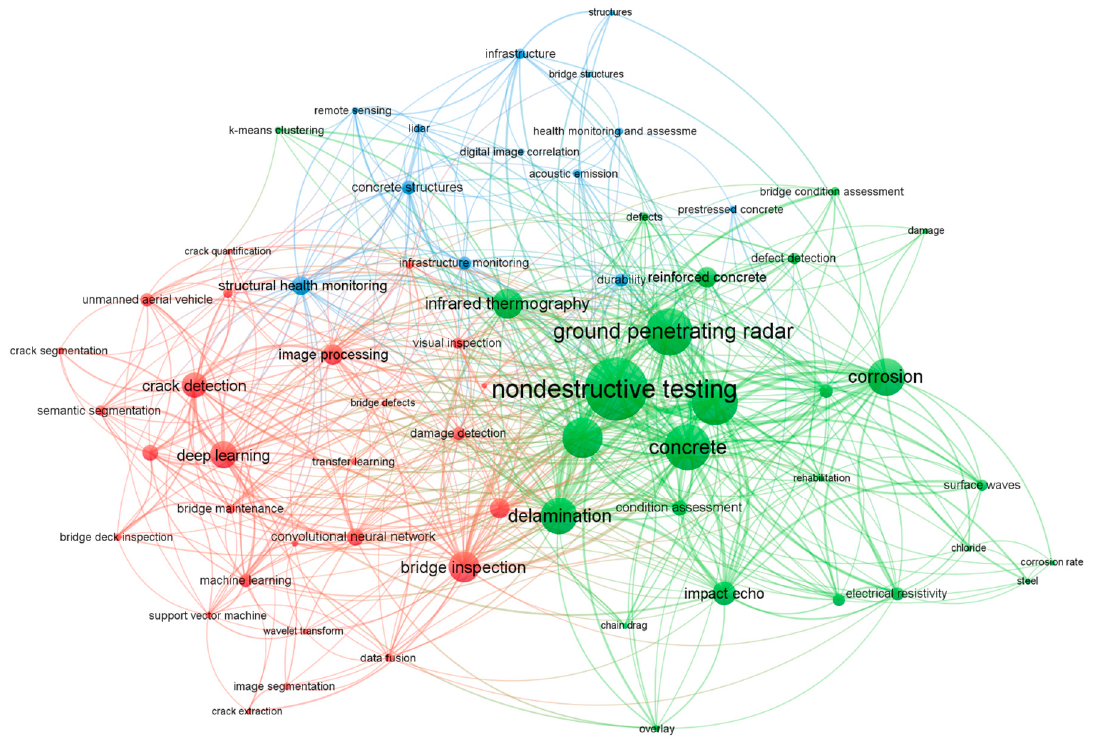
Buildings 2023 , 13 , x FOR PEER REVIEW Figure 10. Co-occurrence network of author keywords in the research on CBD_NDT . Figure 10. Co-occurrence network of author keywords in the research on CBD_NDT.